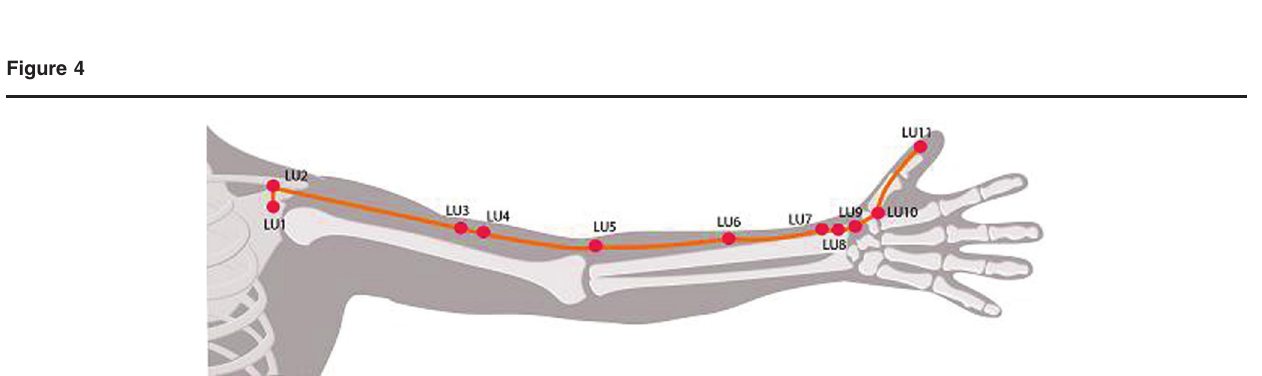
Meridian point, conception vessel 17. Image courtesy of miridiatech. com.